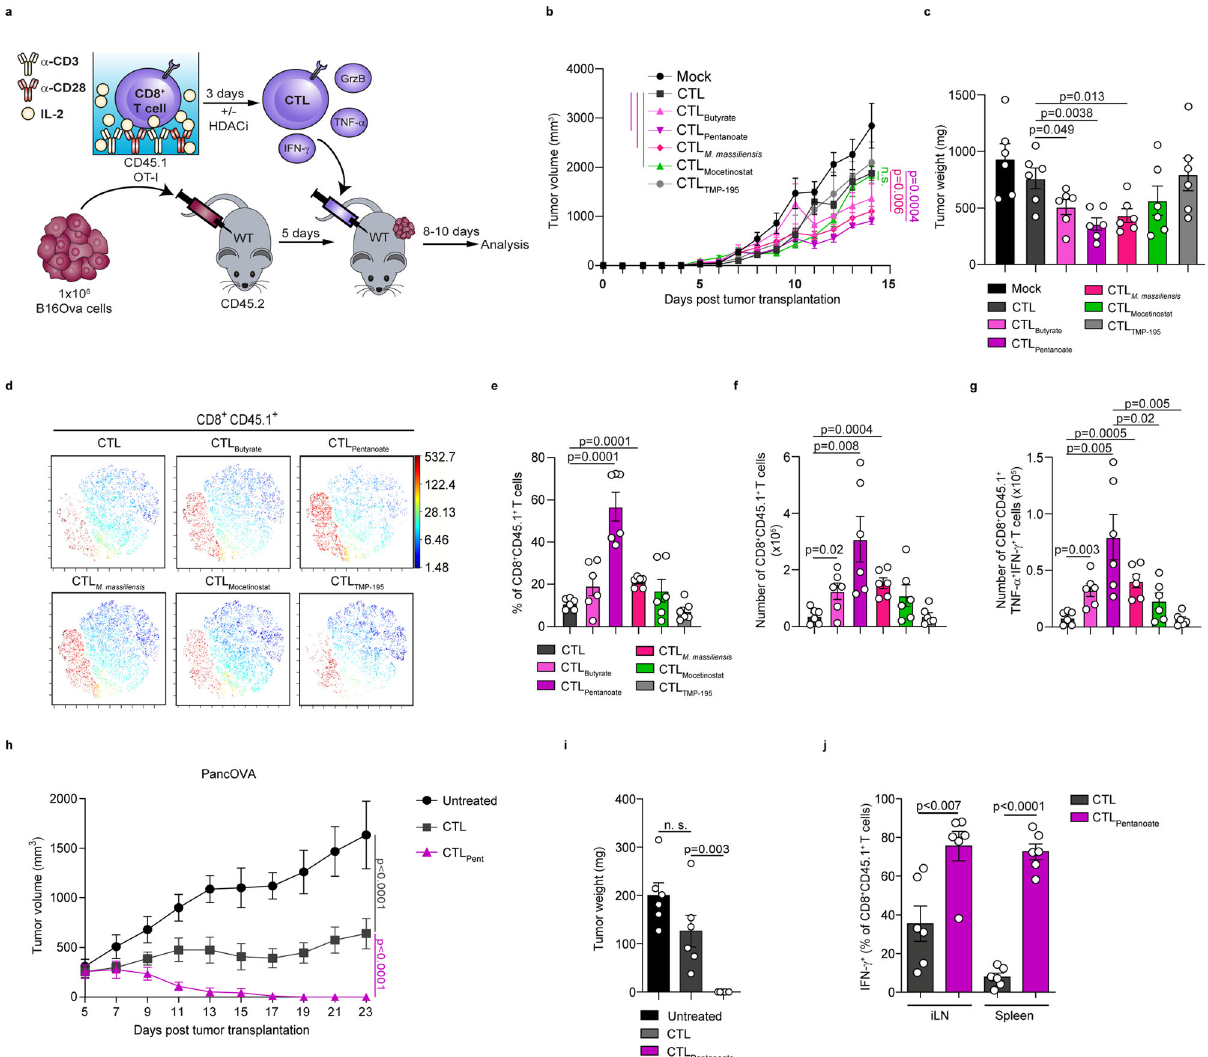
Fig. 3 Pentanoate enhances anti-tumor activity of antigen-speci fi c CTLs. a Experimental design for the role of SCFAs in promoting anti-tumor immunity . b – g After three days of pretreatment with indicated HDAC inhibitors, CD8 + CD45.1 + OVA-speci fi c CTLs were transferred intraperitoneally (i.p.) into CD45.2 + mice bearing 5-days old B16OVA tumors. Tumor volume ( b ) and tumor mass ( c ) were analyzed on day 14 after inoculation of tumor cells ( n = 6 mice/group combined from two independent experiments). The t-SNE plots in ( d ) show CD8 + CD45.1 + cells among lymphocytes from the tumor-draining LNs. The percentage ( e ) and total cell number ( f ) of transferred CD8 + CD45.1 + OT-I CTLs in the tumor-draining LNs at day 14 after tumor inoculation are shown. In g the total cell numbers of transferred antigen-speci fi c IFN- γ + TNF- α + CTLs were examined on day 14 after inoculation of B16OVA tumors in tumor-draining LNs (in e – g , n = 6 mice/group combined from two independent experiments). h – j OVA-speci fi c CD45.1 + CTLs pretreated with pentanoate were adoptively transferred into CD45.2 + mice bearing 5-days old PancOVA tumors. Tumor volume ( h ) and tumor weight ( i ) were determined on day 23 post tumor inoculation. In j frequencies of transferred IFN- γ -producing CD8 + T cells in draining LNs and spleens were analyzed on day 23 post tumor inoculation ( n = 6 mice/group combined from two independent experiments). Multiple group comparison ( b , h ) was performed by a linear-mixed effects model with Tukey correction. The two-tailed unpaired Student ’ s t -test was applied to compare two groups (n.s. = not signi fi cant; results are shown as mean ± s.e.m). Source data are provided as a Source data fi